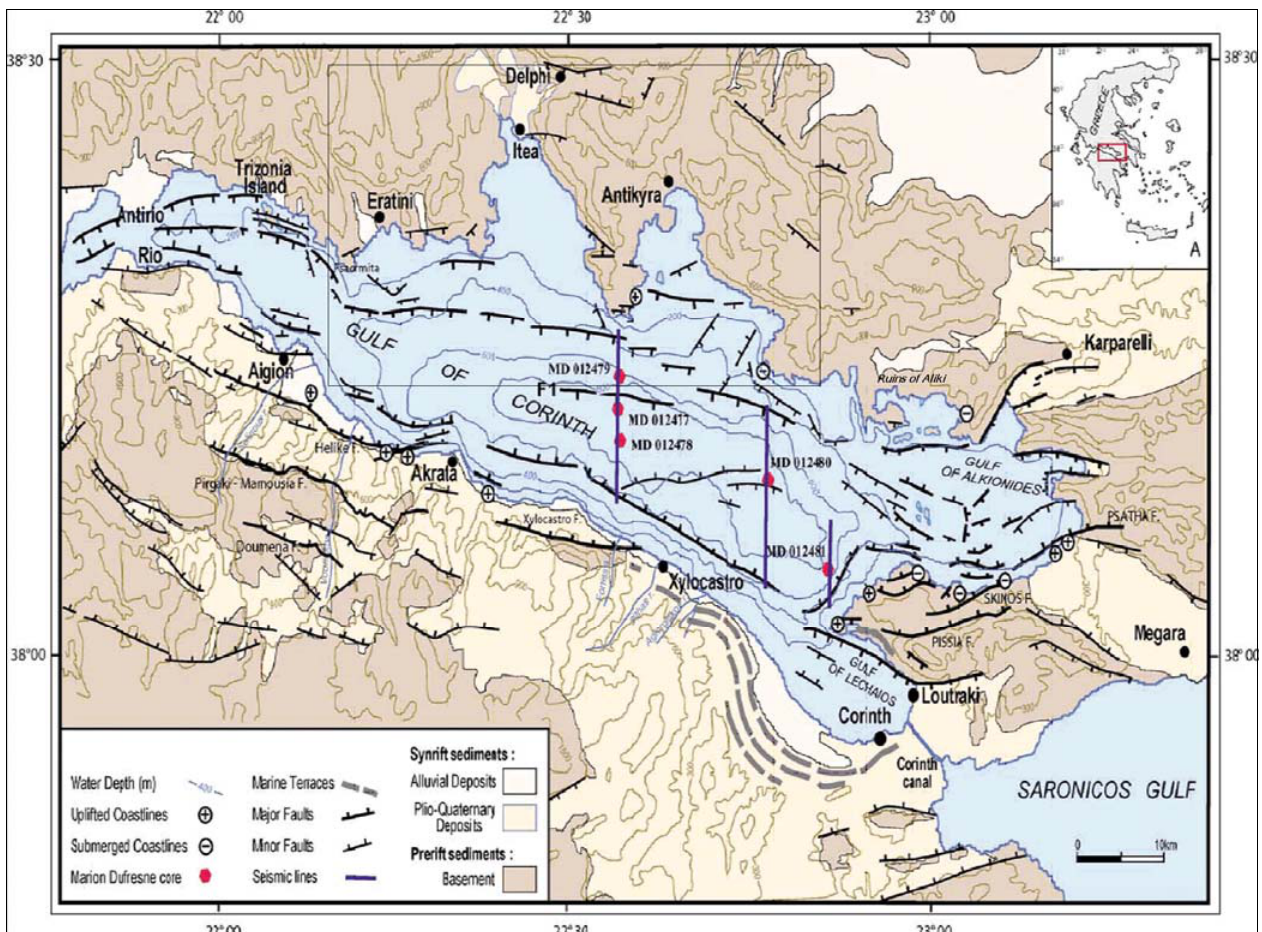
Figure 1. Structural map of the Gulf of Corinth [7] and the location of the test